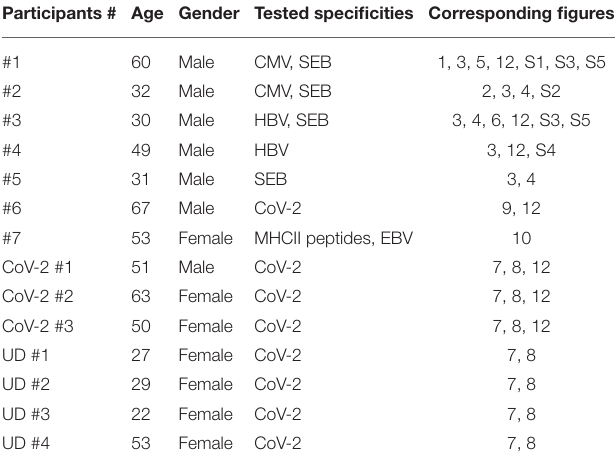
TABLE 1 | Demographic characteristics of the participants. Participants # Age Gender Tested specificities Corresponding